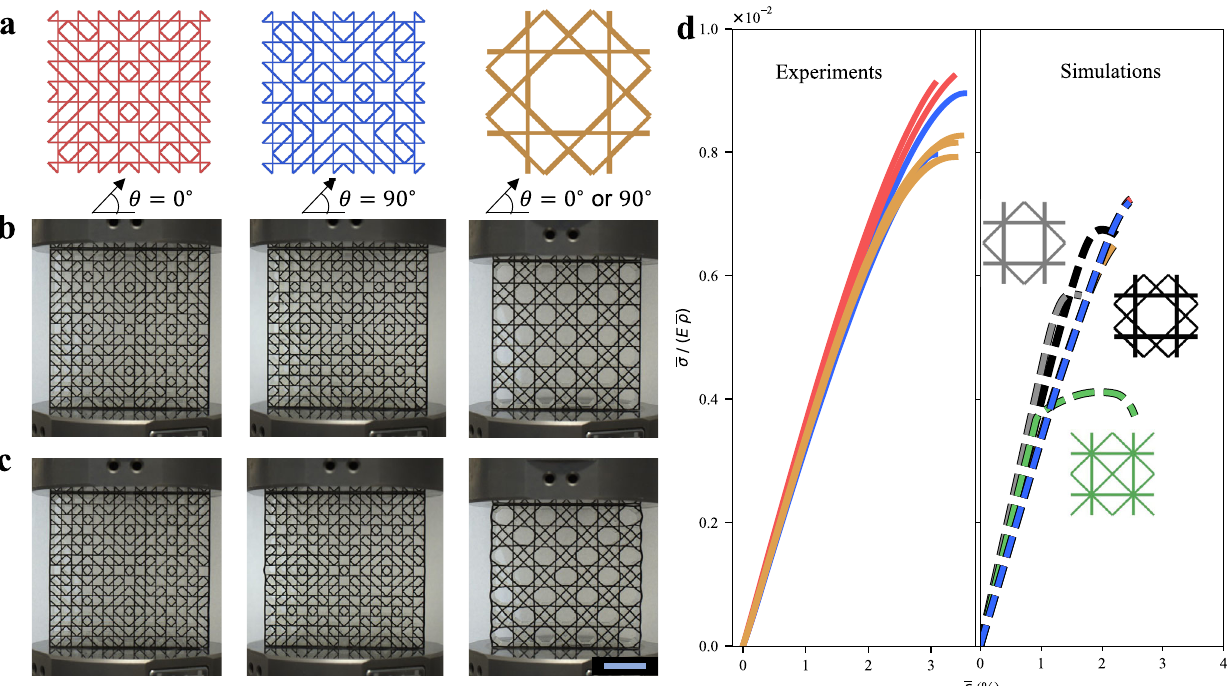
Fig. 4 Uniaxial compression experiments and simulations of 3D-printed fi nite-size lattices. a Experimentally tested unit cells. Snapshots of b un-deformed and c deformed (just before failure) 3D-printed samples at ~3.3% applied strain. d Normalized experimental and numerical stress-strain curves for the symmetric-inverse-designed architecture (at two different loading angles), sponge-inspired designs, and typical grid-like structures. The effective stress is normalized by the base material ’ s Young ’ s modulus (see the “ Materials and methods ” section) and relative density. n = 4 samples are tested for the symmetric-inverse-designed architecture (2 for each loading angle), while n = 3 samples for the sponge-inspired-b design. Curves are color-coded according to the unit cells depicted in ( a ) and ( d ). Scale bar 20 mm for ( b ) and ( c